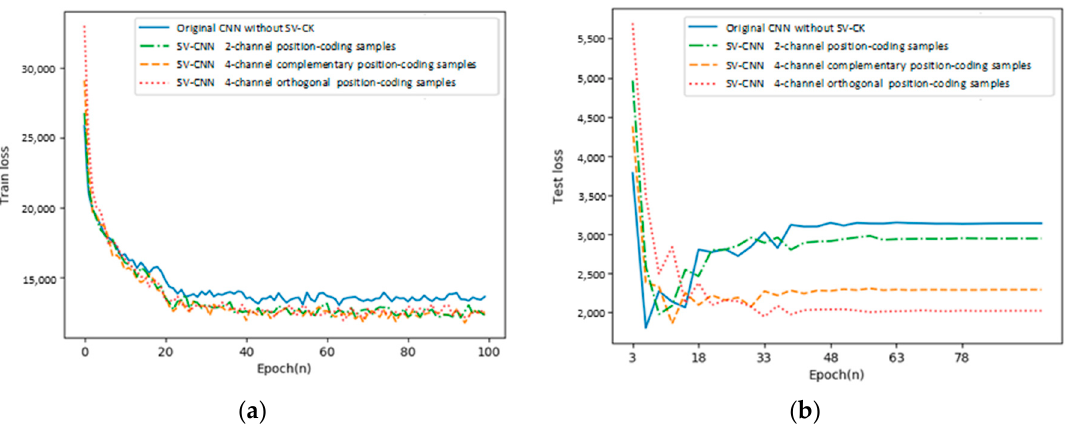
Figure 7. Training loss and testing loss of the CNN and SV-CNN trained using samples with different forms of position-coding; ( a ) training loss; ( b ) testing loss.